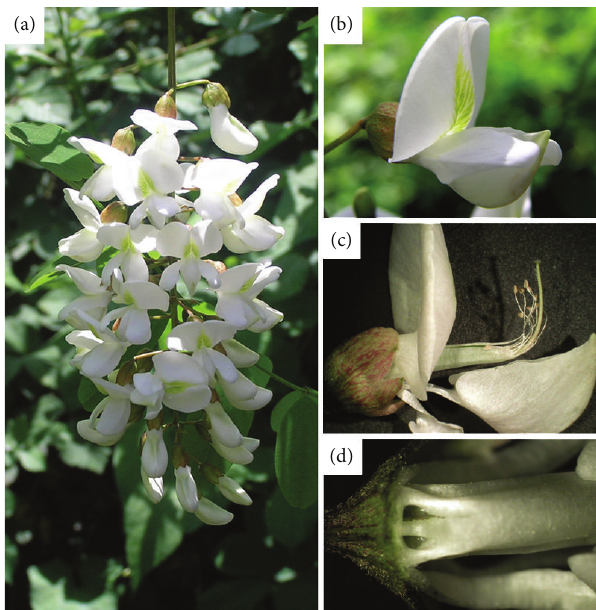
Figure 1: Robinia pseudoacacia inflorescence (a) and details of flowers: papilionaceous corolla (b), staminal column of ten stamens and a single pistil from an opened carina (c), and nectar at the base of the corolla